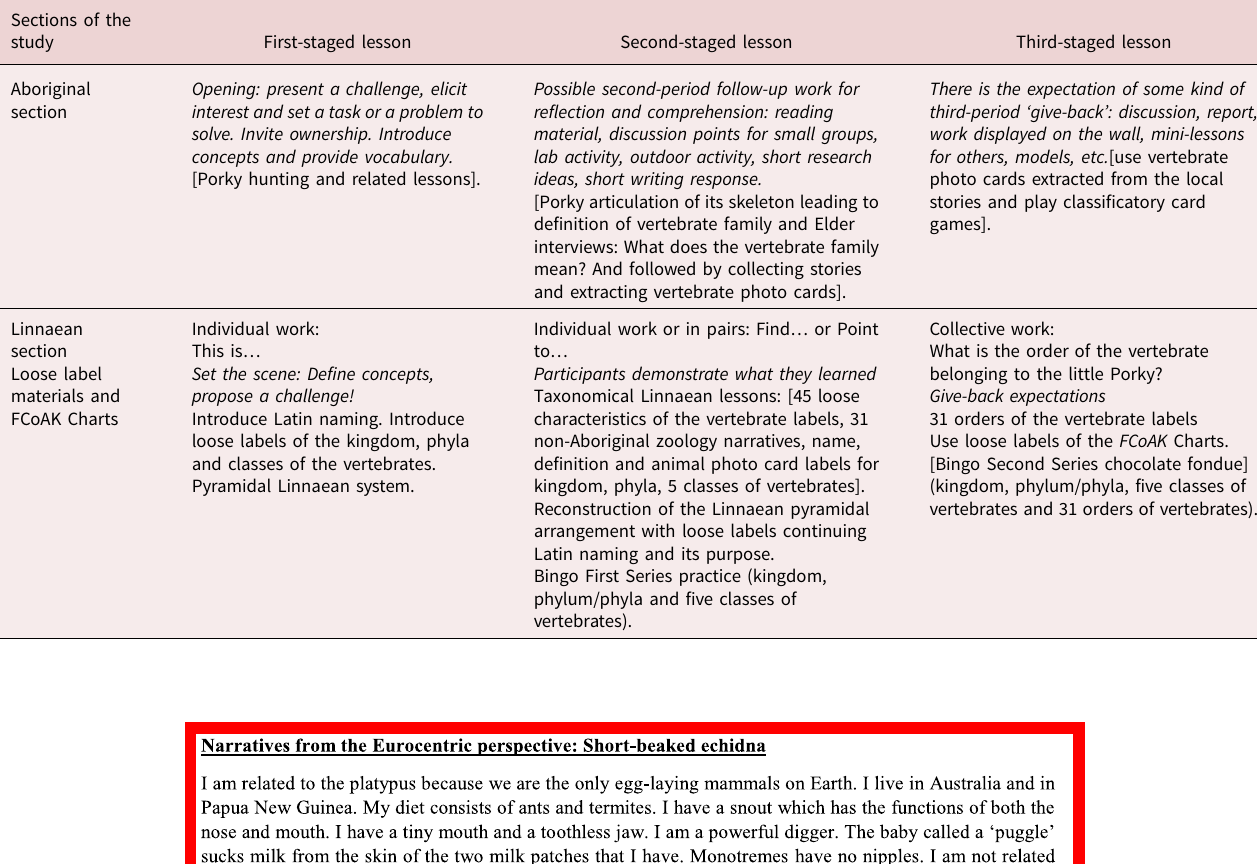
Table 2. Macro-sequence: comparison of aboriginal and non-aboriginal (three-staged lesson)